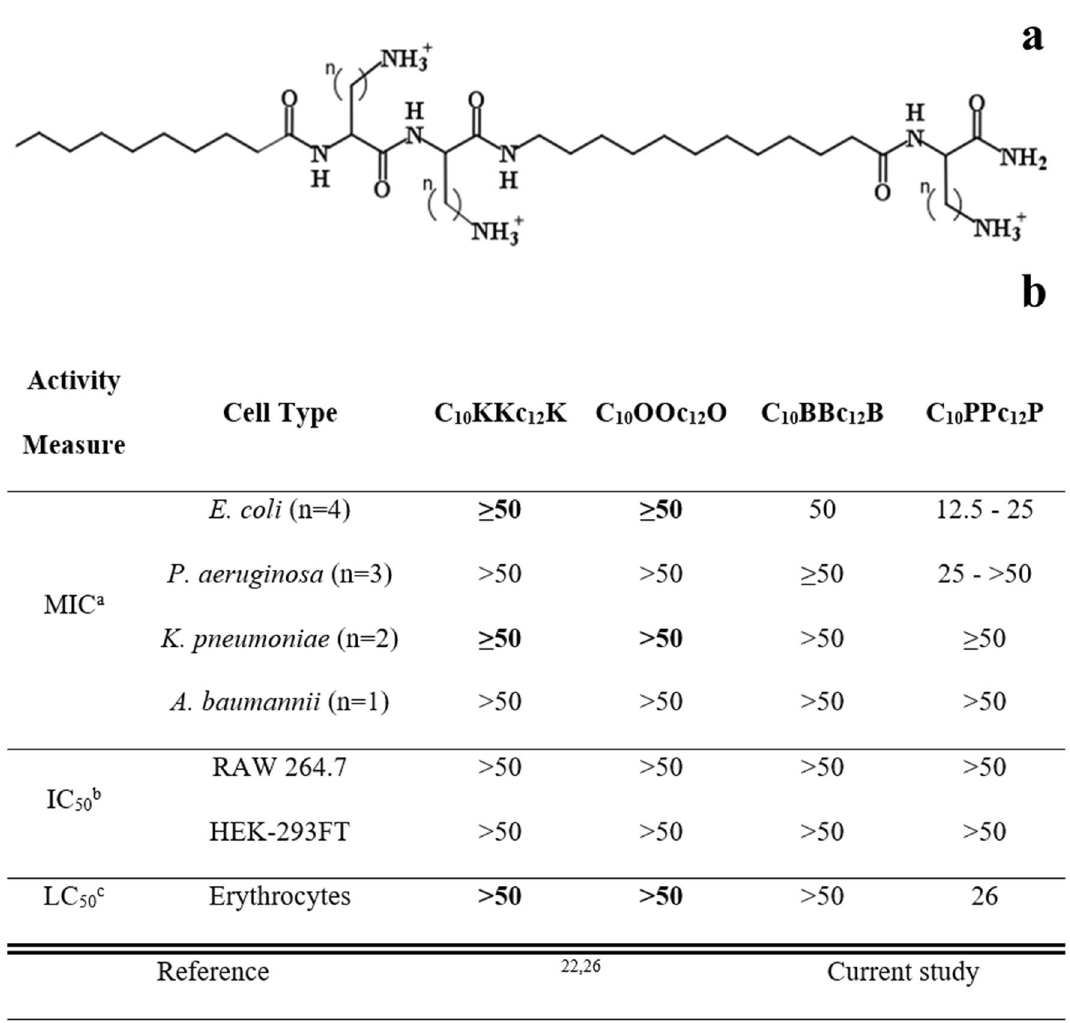
Figure 1. Basic Characterization of Pentamer Analogs. ( a ) General molecular structure of the A 10 CCa 12 C series; where A 10 and a 12 stand for decanoyl and aminododecanoyl, whereas “C” represents one of the following cationic amino acids: lysine (K), ornithine (O), diaminobutyric acid (B) or diaminopropionic acid (P) where n (methyl groups number on each side chain) equals 4, 3, 2 or 1, respectively. Molecular weights of these analogs are 753, 711, 669 and 627 g/mol, for K, O, B and P, respectively. ( b ) Cytotoxic activity of pentamer analogs. a , Minimal inhibitory concentrations determined using the broth microdilution method (n, number of tested strains); b , Pentamer concentration causing 50% inhibition of cells respiration, using Alamar blue; c , Pentamer concentration causing 50% hemolysis of murine RBC. Published data appear in bold fonts, shown for comparison purposes.